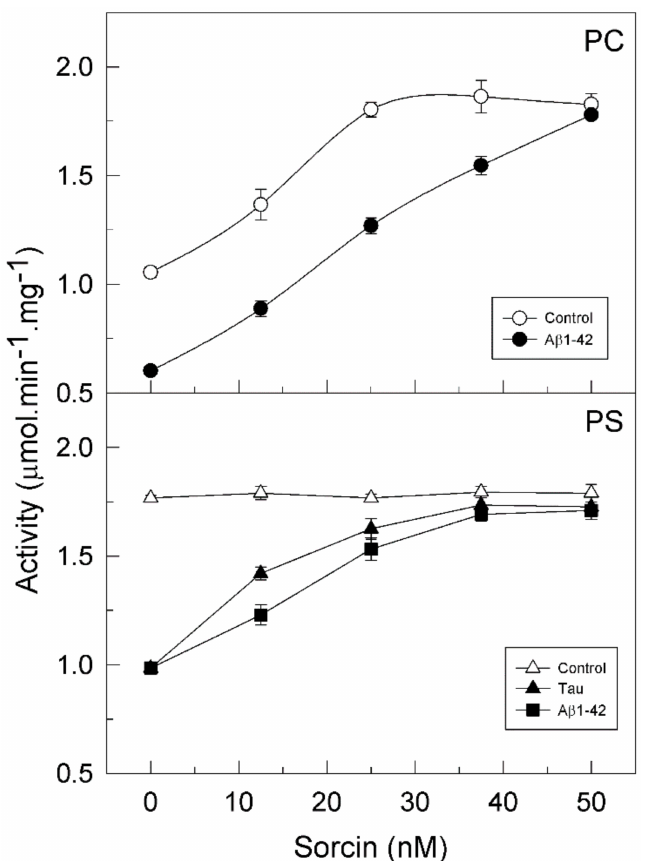
Figure 1. Sorcin activates the plasma membrane Ca 2+ -ATPase (PMCA) activity and prevents the inhibition of the pump by amyloid- β peptide (A β 1-42) and tau. Purified PMCA (2.5 µ g) was reconstituted with phosphatidylcholine (PC) ( ) or phosphatidylserine (PS) ( ∆ ), and incubated for (cid:35) 2 min at 37 ◦ C, with Ca 2+ and increasing concentrations of sorcin, in the absence or presence of 30 µ M A β 1-42 ( • (cid:4) ) or 300 nM tau ( (cid:78) ) in 25 µ L. Afterward, samples were further diluted up to 1 mL in assay medium (final concentrations of A β and tau were 0.75 µ M and 7.5 nM, respectively). The Ca 2+ -ATPase activity was measured as described in the Methods Section. Data are mean ± SE of eight experiments performed with three